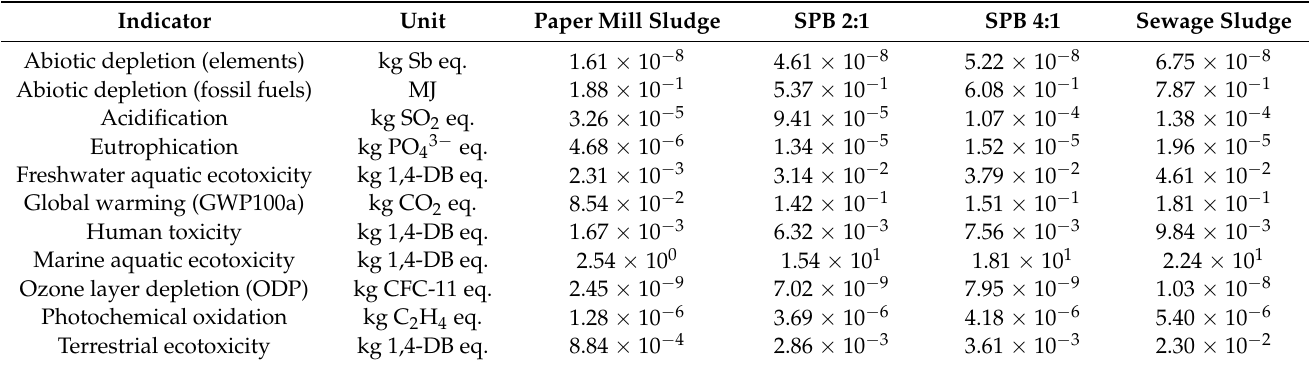
Table 7. LCIA results (CML-IA baseline, v.4.4, 2015) of the pelletized fuels for the production of 1 MJ